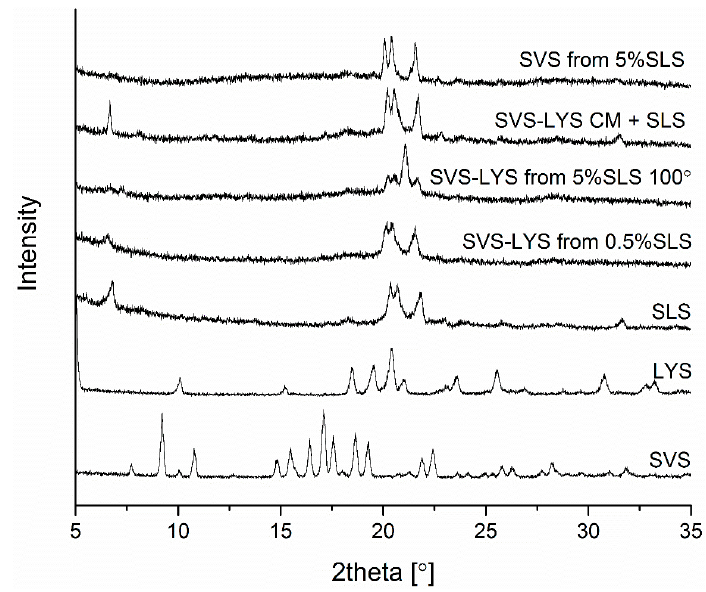
Figure 2. XRPD diffractograms of SVS, LYS, SLS, and the spray-dried formulations of SVS-LYS from 0.5% SLS, SVS-LYS from 5% SLS, SVS from 0.5% SLS, and SVS-LYS CM + SLS.